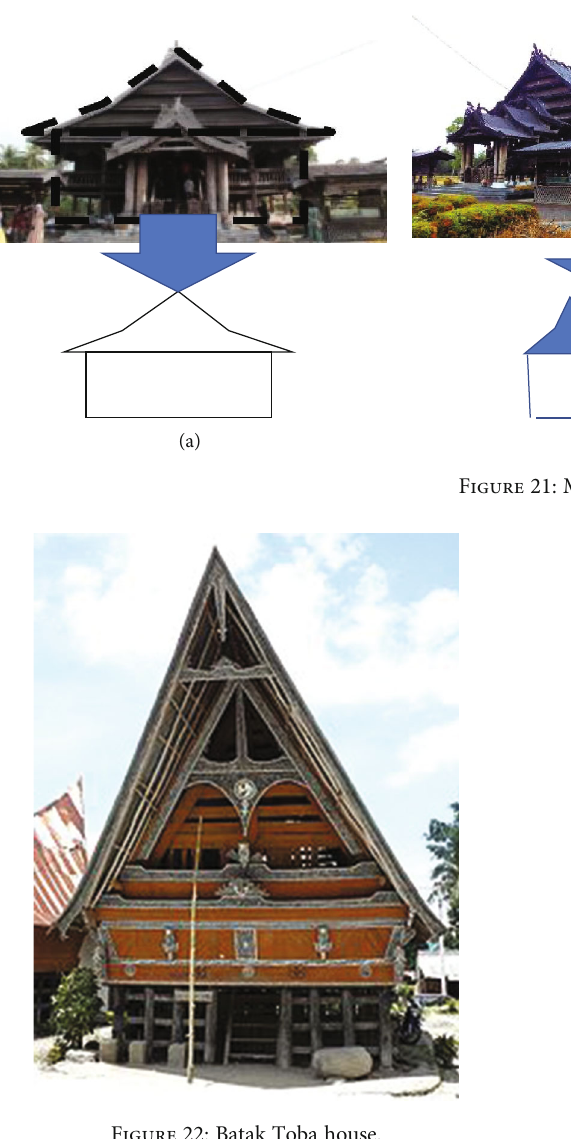
Figure 22: Batak Toba